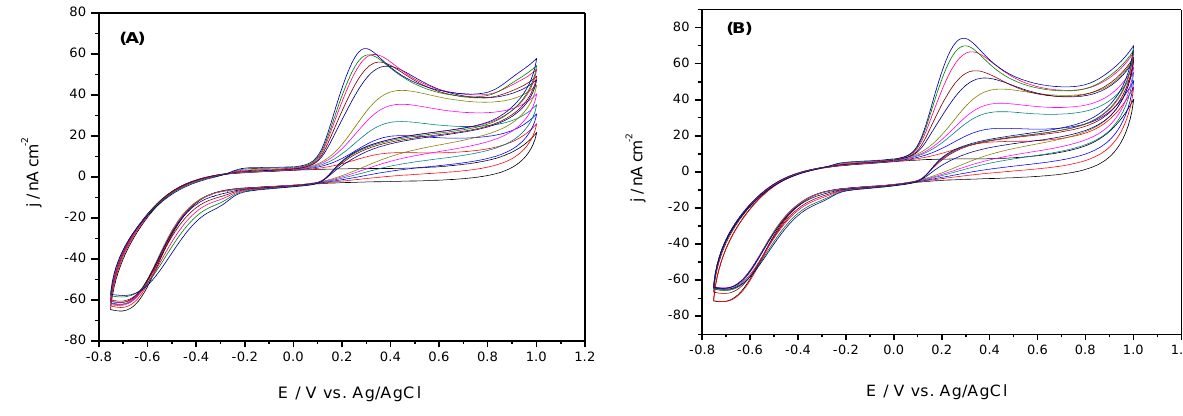
Figure 2. Cyclic voltammograms (CV) recorded at ( A ) M-GEC; and ( B ) M-SZ-GEC in 50 mM PBS supporting electrolyte with increasing concentrations of AA: 100 µM, 200 µM, 300 µM, 400 µM, 500 mM, followed by the addition of consecutive concentrations of DA: 10 µM, 20 µM, 30 µM, 40 µM, 50 mM; Pt reference electrode and Ag/AgCl